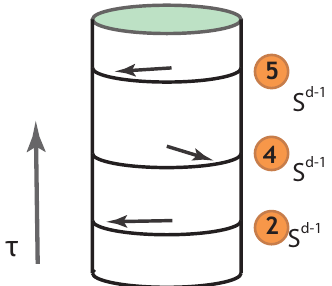
Figure 10. The (cid:12)ve-point correlation function in the plane R d can be mapped through a Weyl transformation to the cylinder R (cid:2) S d (cid:0) 1